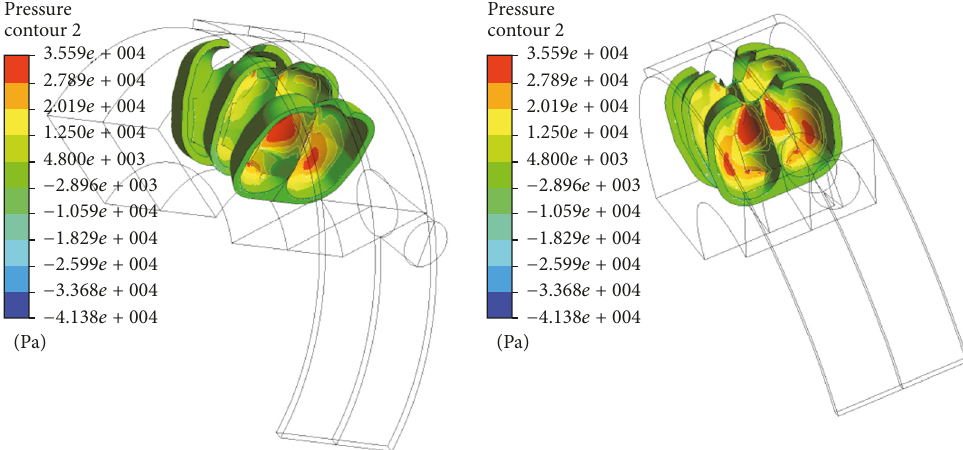
Figure 15: Pressure distribution at some degree of rotation of reference bucket design (PCD = 400 mm).